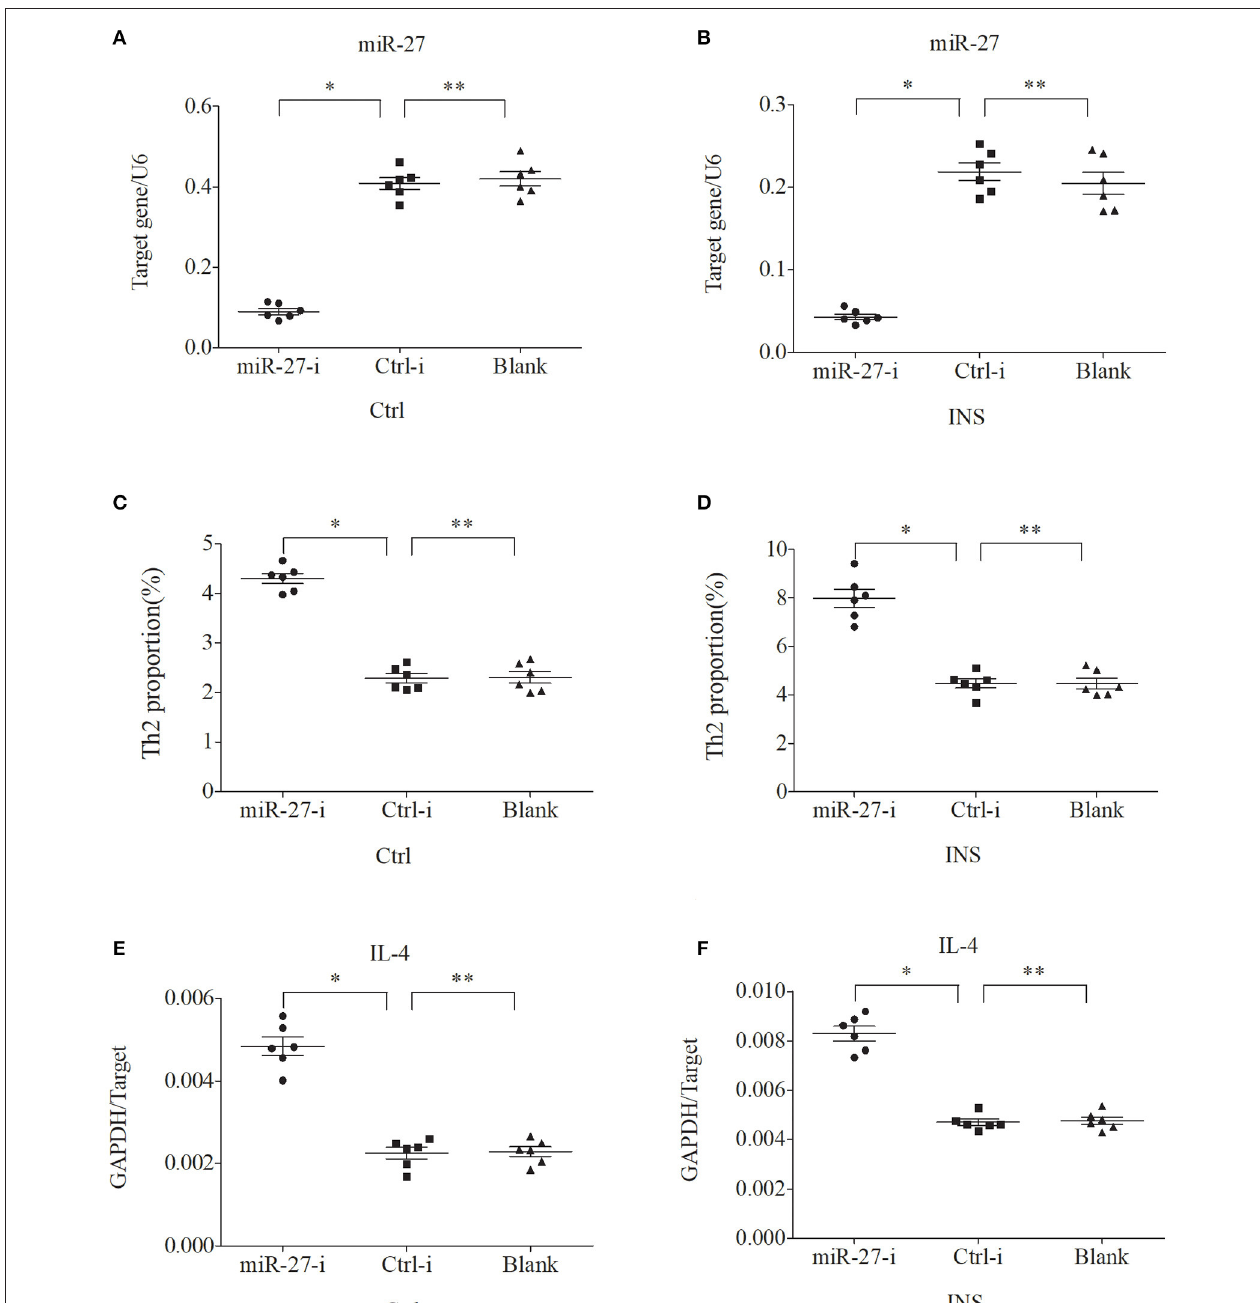
FIGURE 7 | Down regulation of miR-27 in PBMCs from controls and INS patients (A,B) increases the percentage of Th2 cells (C,D) and the expression of IL-4 mRNA (E,F) . * P < 0.05 and ** P >